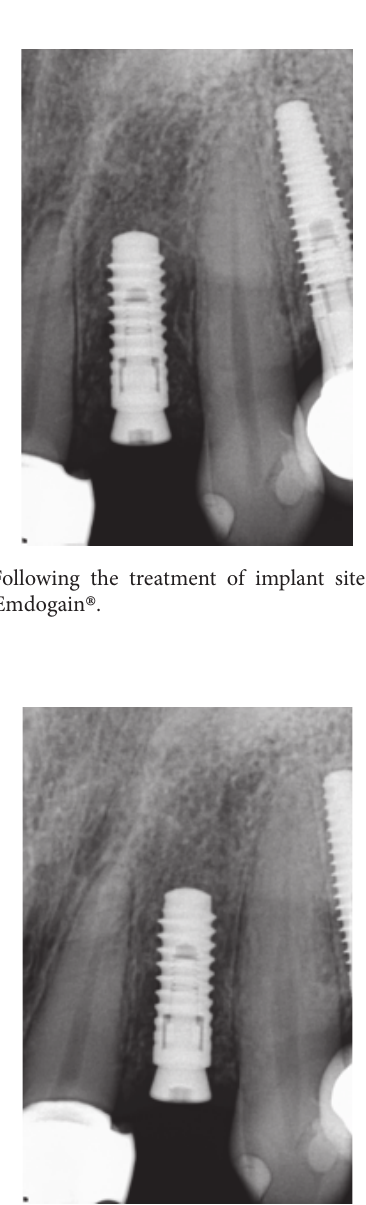
Figure 9: PA radiograph 4 months following bone grafting around the